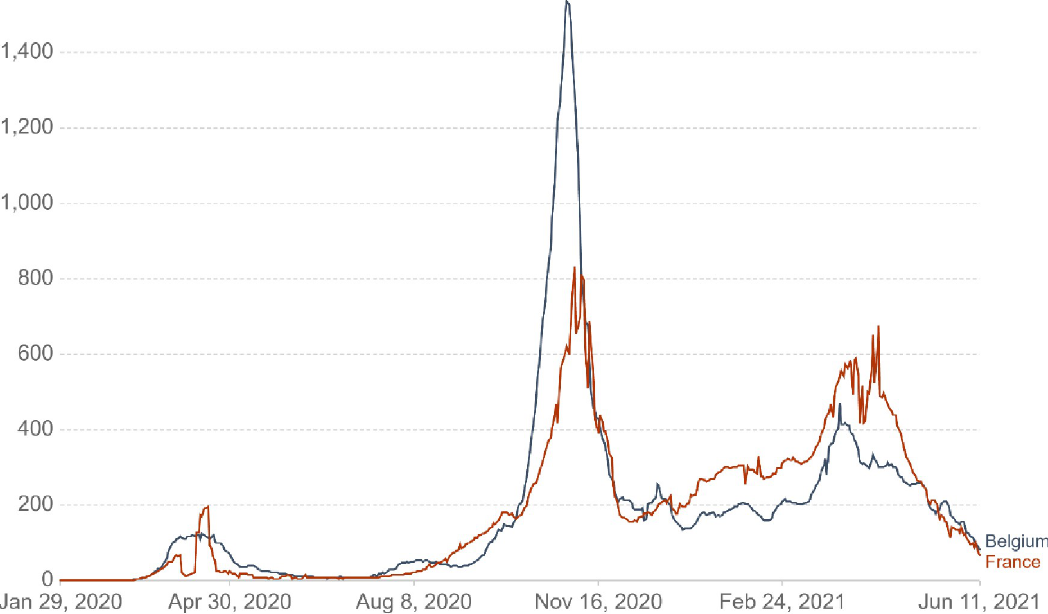
Fig 1. Daily new confirmed COVID-19 cases per million people in Belgium and